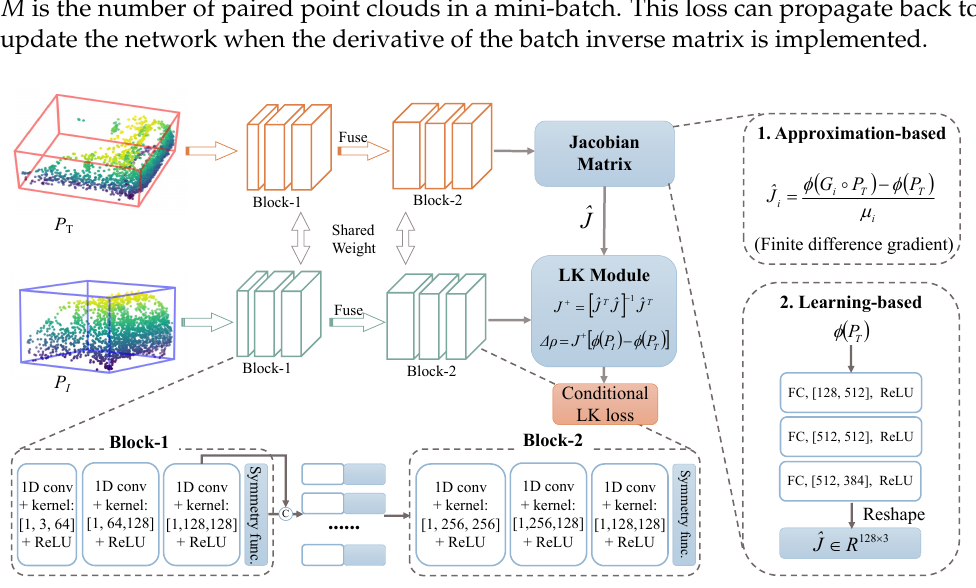
Figure 3. Illustration of the proposed state estimation subnetwork (SES). Firstly, the SES extracts the shape descriptors of the paired point clouds using the designed architecture. Its details are shown in the bottom dashed box. Subsequently, the Jacobian matrix is computed by one of the solutions: approximation-based or learning-based. Its details are shown in the right dashed box. Finally, the LK module generates the incremental warp parameters ∆ ρ